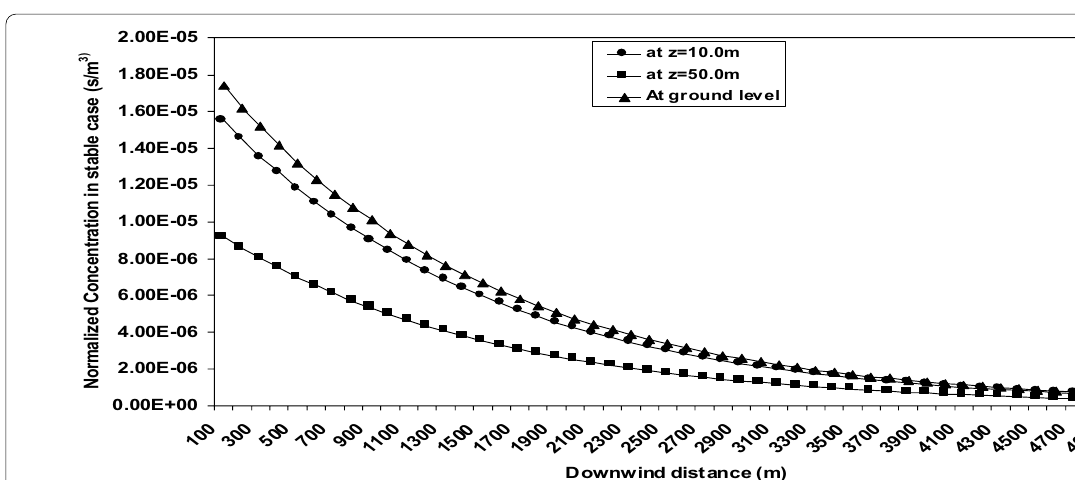
Fig. 4 The relation between decay distance, the mixing height with downwind distance